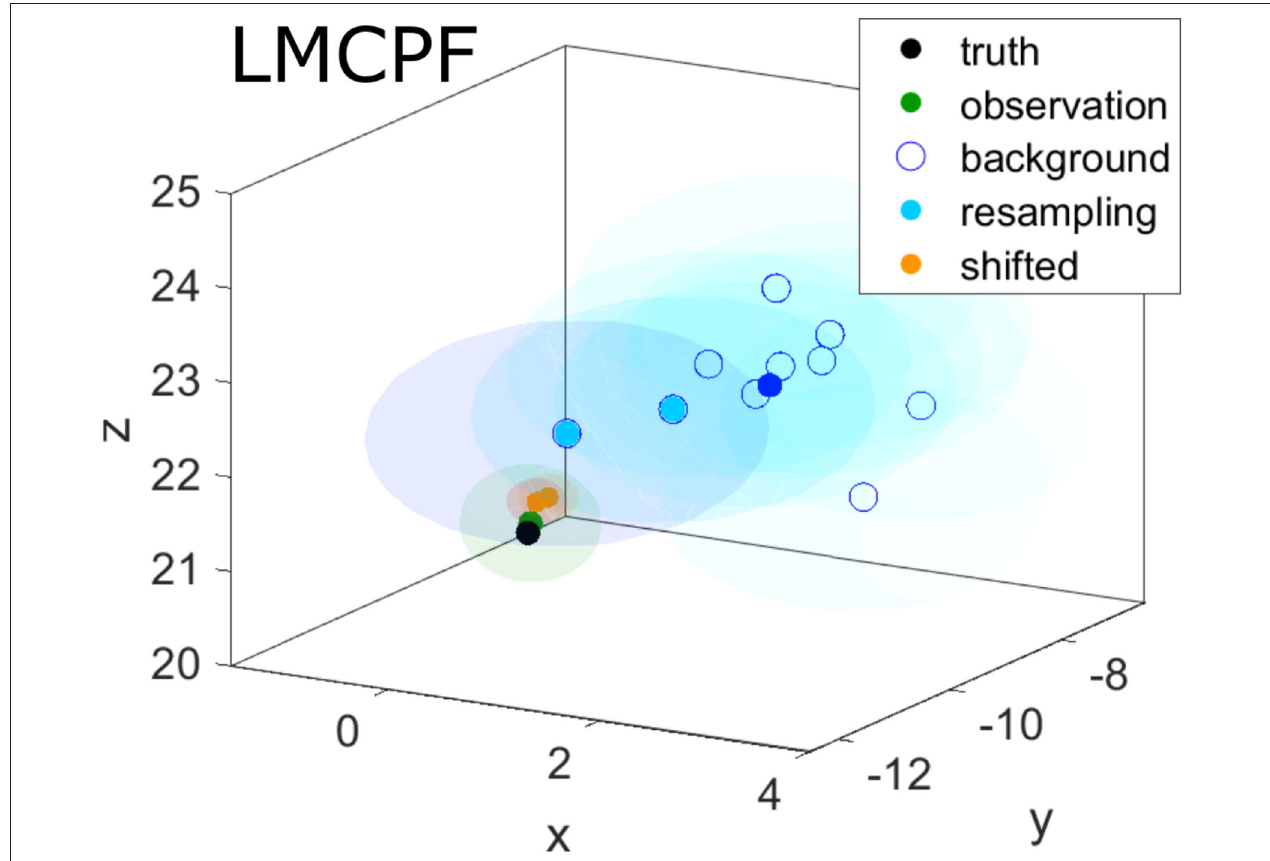
FIGURE 3 | A single assimilation step is carried out with the LMCPF method. The observation (green point) is located outside of the background ensemble of size L 10 with the ensemble mean represented by the dark blue point. The particles chosen in the stratified resampling step (light blue points) are shifted toward the = observation (orange points). The particle uncertainty parameter κ is set to one. The shaded areas denote Gaussian ellipsoids with respect to the corresponding covariance matrices. Darker colored ellipsoids around the background particles denote larger weights w ( a , l ) defined in Equation